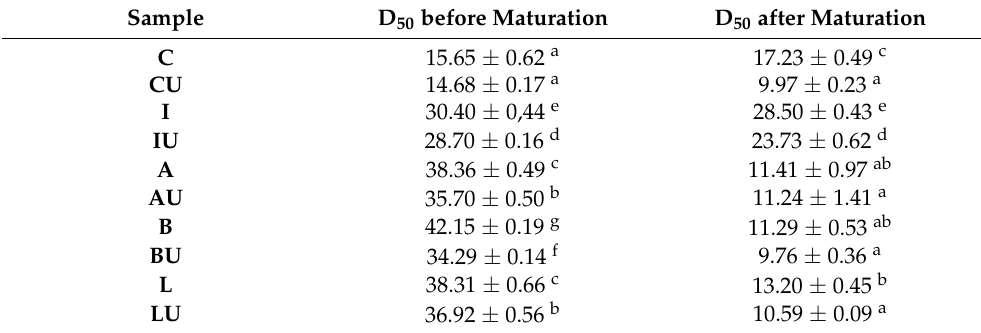
Table 2. The value of median D 50 of ice cream mixes before and after maturation (for 24 h; at 4 ◦ C).